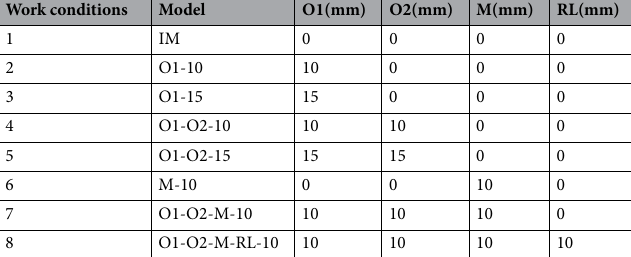
Table 1. Assumed influenced dimension of each